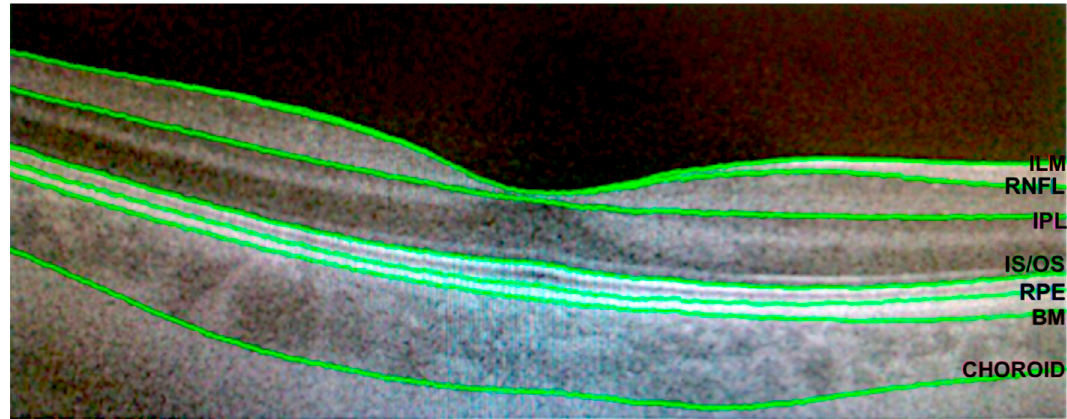
Figure 1. Segmentation of the different retinal layers as well as the choroid with the DRI Triton swept source optical coherence tomography (SS-OCT). The provided lines are as follows: ILM, inner limiting membrane line; RNFL, retinal nerve fiber layer line; IPL, inner plexiform layer line, IS/OS, inner/outer segments line; RPE, retinal pigment epithelium line; and choroid line.